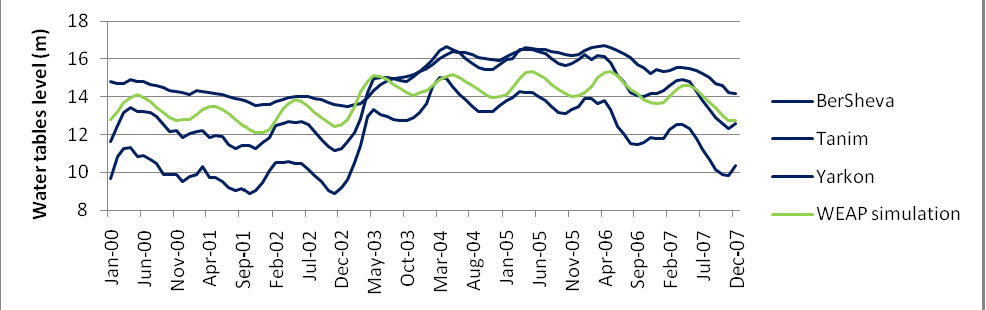
Figure 5. Comparison of WEAP simulated average change in aquifer level vs. measurements in different parts of the Western Mountain